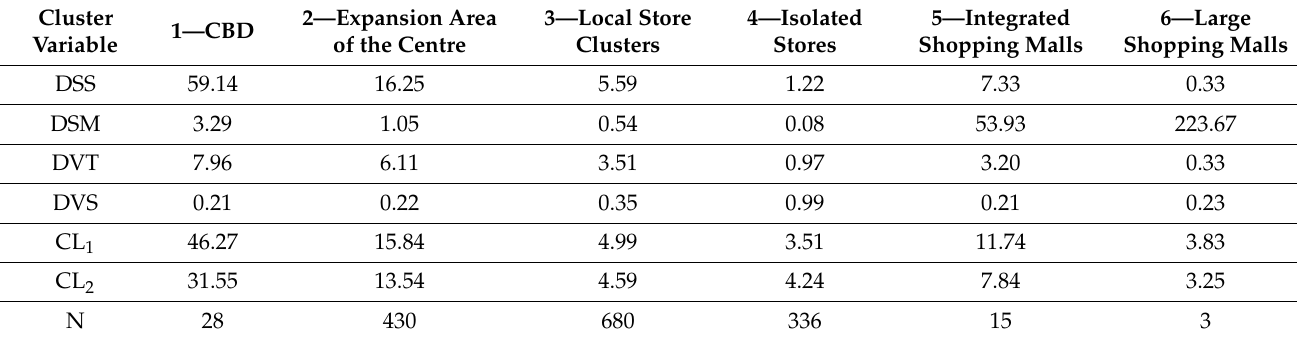
Table 3. Commercial Variables in 2002—Mean Value considering Cluster